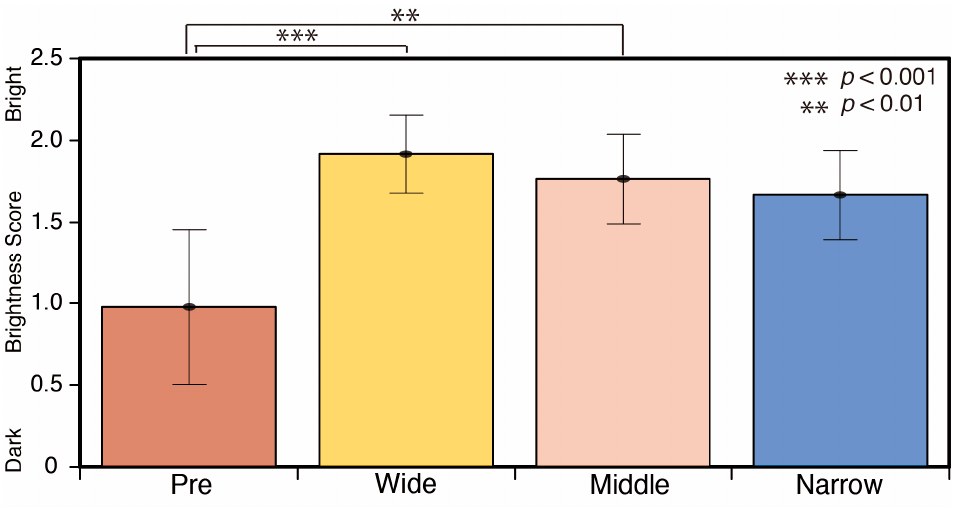
Figure 17. Brightness and spotlight size scores.